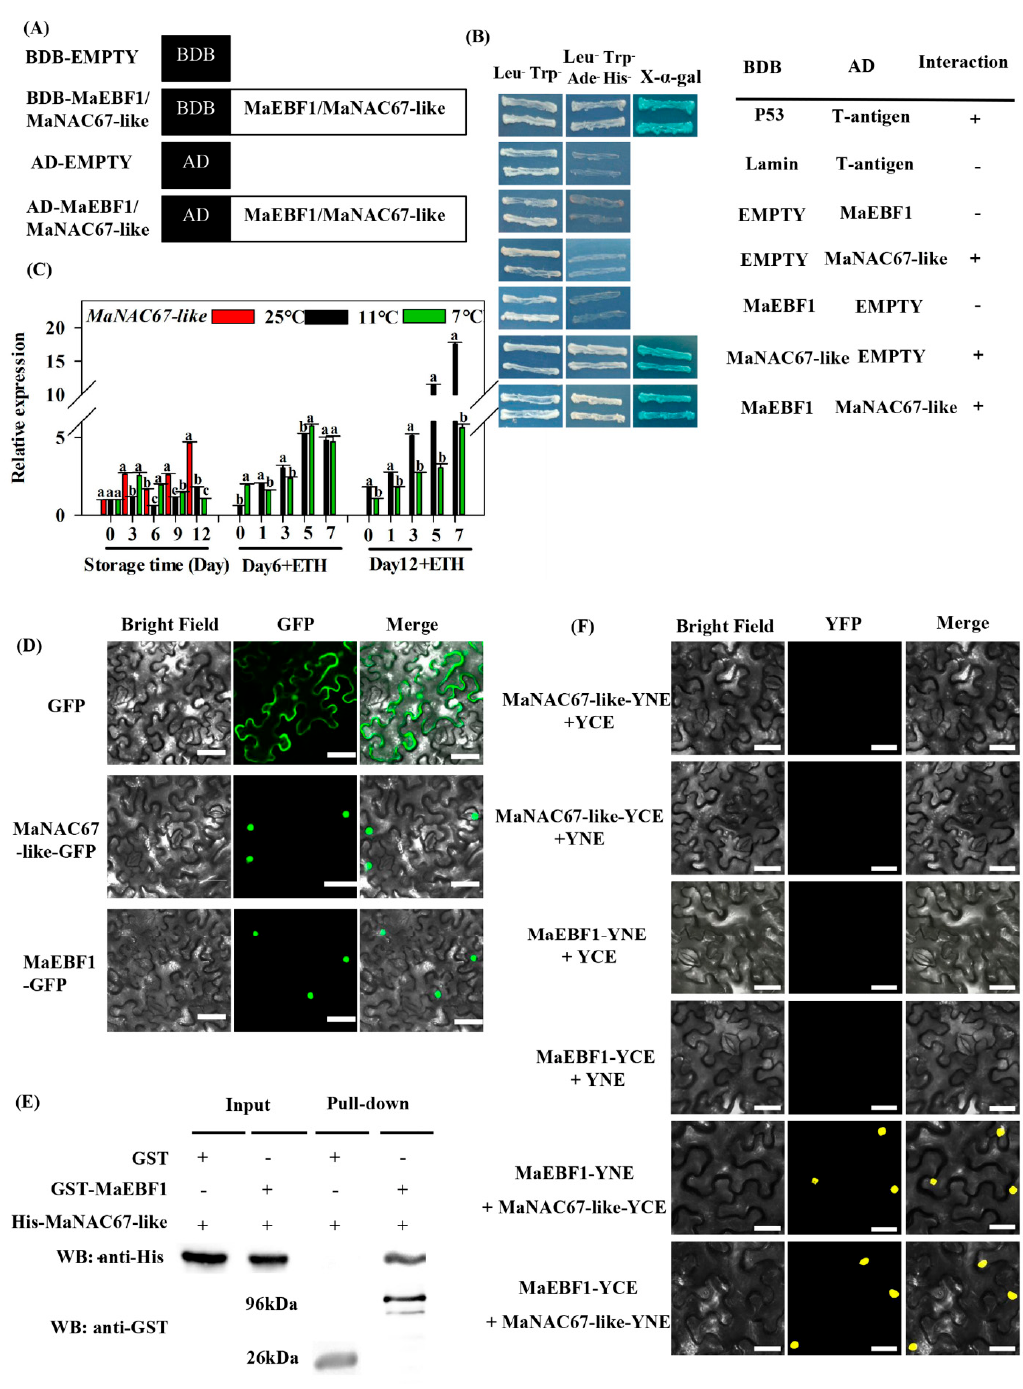
Figure 4. Interaction between MaEBF1 and MaNAC67-like proteins. ( A , B ) Y2H assay showing the interaction of MaEBF1 with MaNAC67-like. Diagram of the di ff erent constructs used in this experiment ( A ); the Y2H yeast strains were co-transformed with MaEBF1 + MaNAC67-like. Yeast cells grew on SD / -Leu-Trp-Ade-His in the presence of 125 µ m Aureobasidin A, and blue plaques served as a positive interaction with chromogenic substrate X- α -gal ( B ); ( C ) the expression profile of MaNAC67-like during cold storage and ripening process; ( D ) the subcellular localization of MaEBF1 and MaNAC67-like proteins. ( E ) In vitro pull-down assay of the interaction between MaEBF1 with MaNAC67-like. ( F ) BiFC analysis of the interactions of MaEBF1 with MaNAC67-like in tobacco leaf epidermal cells. Bars, 50 µ